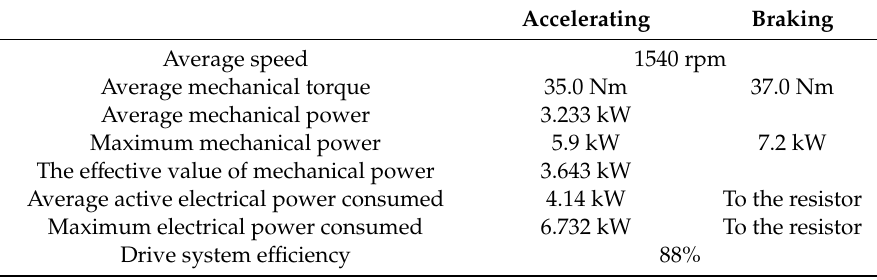
Figure 23. Jib rotation drive’s operating cycle: ( a ) set courses of rotational speed, ( b ) loading moment and calculated mechanical power. Table 6. Measurement results for the cycle of the jib rotation drive.